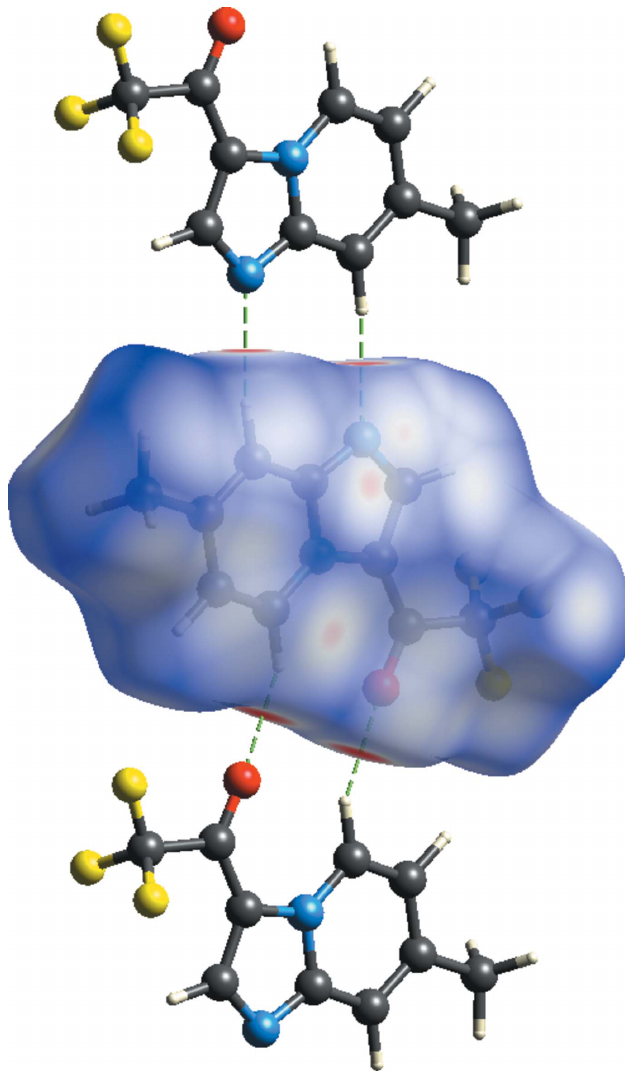
Figure 6 Hirshfeld surface of the title molecule mapped over d norm